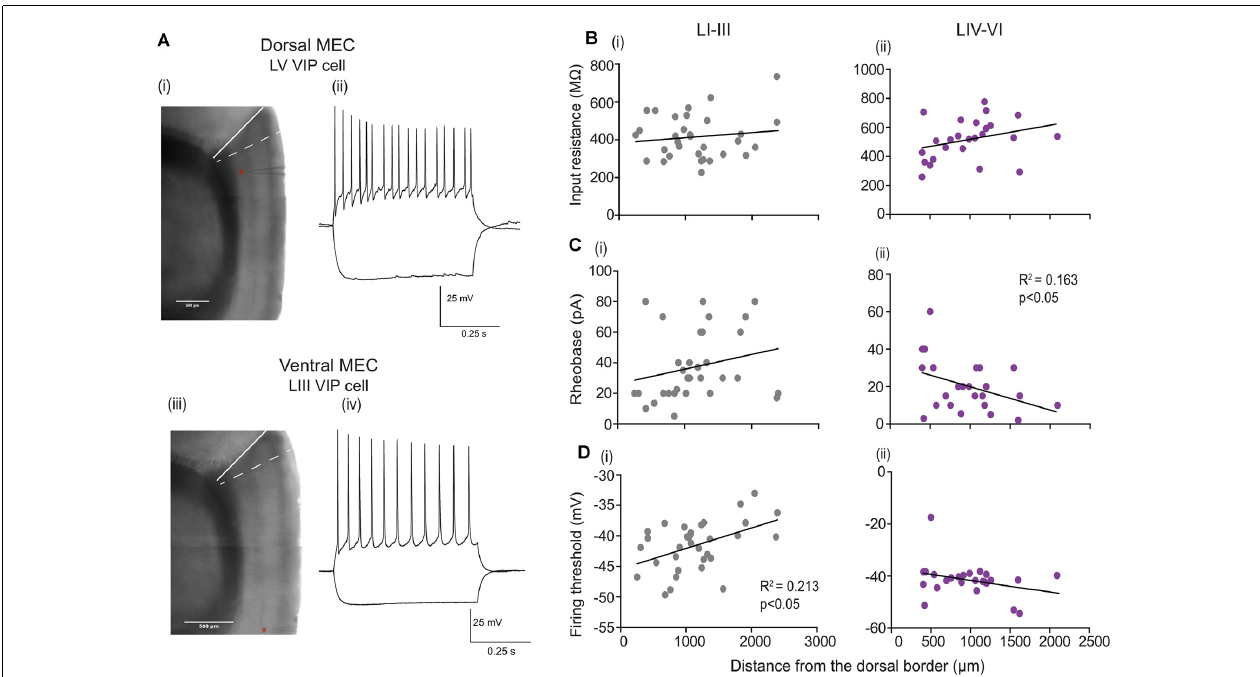
FIGURE 3 | Passive and active properties as a function of layer and location along the Dorsal-Ventral axis. (A) (i and iii) Parasagittal brain slice under the experimental microscope (aligned and blended composites of low magnification 4 × images). The border between the postrhinal cortex and sensory cortex is indicated by a white solid line, while the dorsal border of the MEC is indicated by a white dashed line. The position of the dorsal cell in (A) Located 286 mm from the dorsal MEC border, and the ventral cell shown in (A) (iv) located 2,128 µ m from the dorsal MEC border, are indicated by a red star near the recording pipette in the respective sections. (A) (ii and iv) Examples of membrane potential responses to − 80 pA (lower traces) and +80 pA (upper traces) current step recorded from (ii) LV VIP cell and (iv) LIII VIP cell. (B–D) Passive and active properties plotted as a function of location and layer for individual VIP cells recorded from the superficial layers LI–III: 35 cells (B–D) (i) and (B–D) (ii) deep layers LIV–VI: 25 cells. In all panels, black lines indicate linear fits to the data. For cells located in the deep MEC significance in slope for (C) (ii) rheobase is observed, and for cells located in the superficial layers significance in slope for (D) (i) firing threshold is